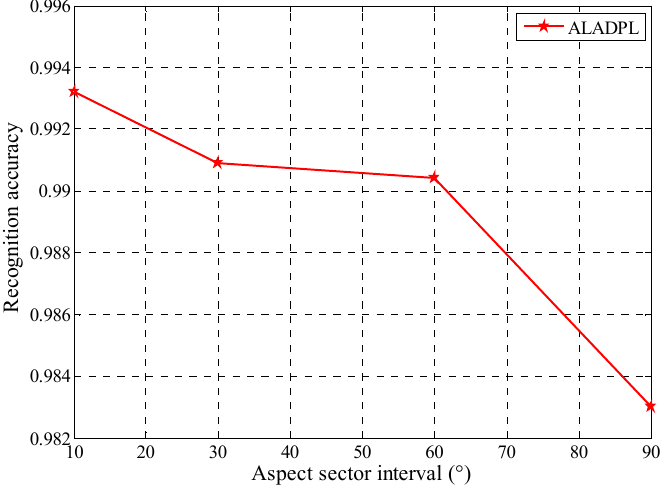
Figure 7. The recognition accuracy of ALADPL with different local aspect sector interval.